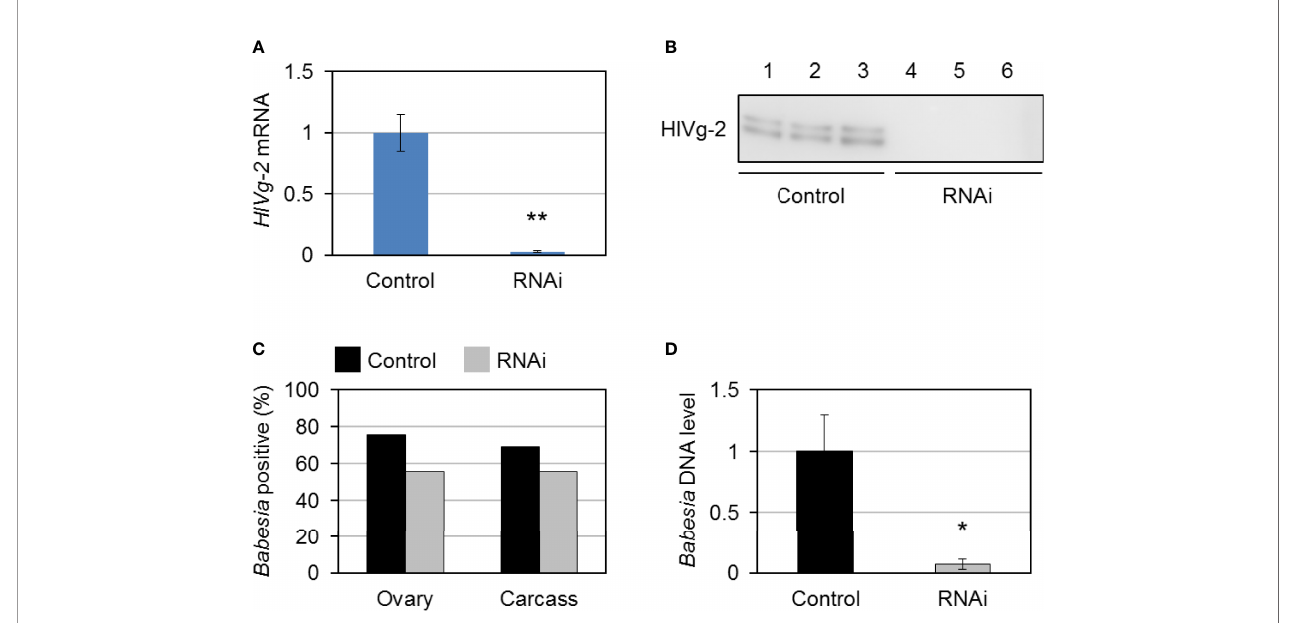
FIGURE 5 | HlVg-2 knockdown by RNA interference (RNAi) in Babesia -infected bovine red blood cells-fed H longicornis female ticks. (A) Total RNA was puri fi ed from the fat body 2 days after engorgement (control group, n = 29; HlVg-2 RNAi group: n = 30). Knockdown ef fi cacy was assessed via real-time PCR. Data represent the mean ± SD. Asterisks indicate the signi fi cant differences between the control and RNAi groups (** P < 0.01 via Student ’ s t-test). (B) HlVg-2 protein detection in the hemolymph of the control and the HlVg-2 RNAi group via western blotting using an antibody against HlVg-2. Lanes 1 – 6 contain equal numbers of ticks (n = 3 per group). (C) B. ovata detection rate in the ovaries (control, n = 29; HlVg-2 RNAi, n = 27) and carcass (control, n = 29; HlVg-2 RNAi, n = 27). (D) Relative abundance of B. ovata DNA in the hemolymph (control, n = 4; HlVg-2 RNAi, n = 7). Data represent the mean ± SD. Asterisks indicate the signi fi cant differences between the control and RNAi groups (* P < 0.05 via Welch's t-test).